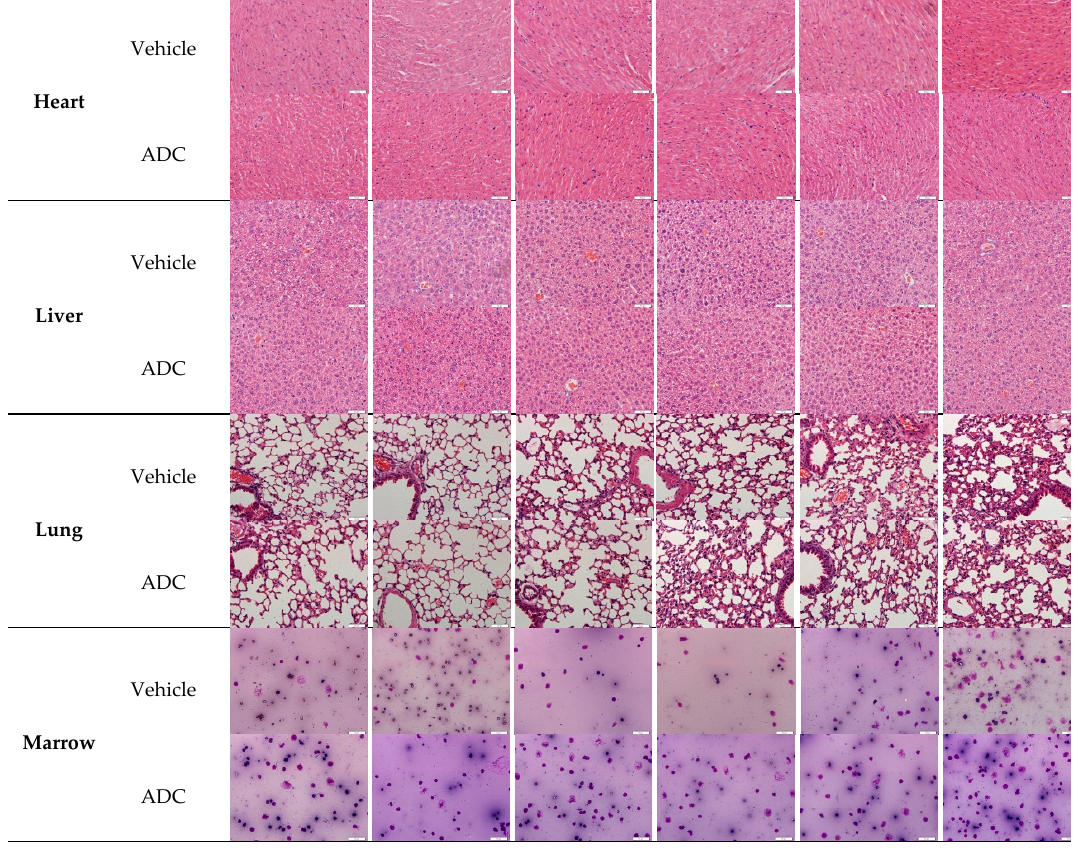
Figure 9. Histopathological studies of VA-based ADC (mil40- 12b ). At the end of the xenograft test, animals ( n = 6/group) in the vehicle and ADC treatment group (2.5 mg/kg) were sacrificed, and the tissue and bone marrow were used for histopathological studies. Scale bar: 46:1; the actual size of each picture is 425 × 320 μ m.